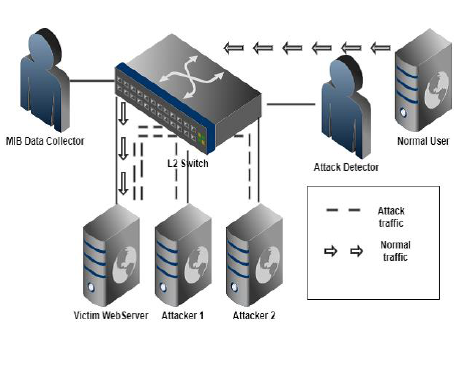
Fig 3: LDoS Testbed